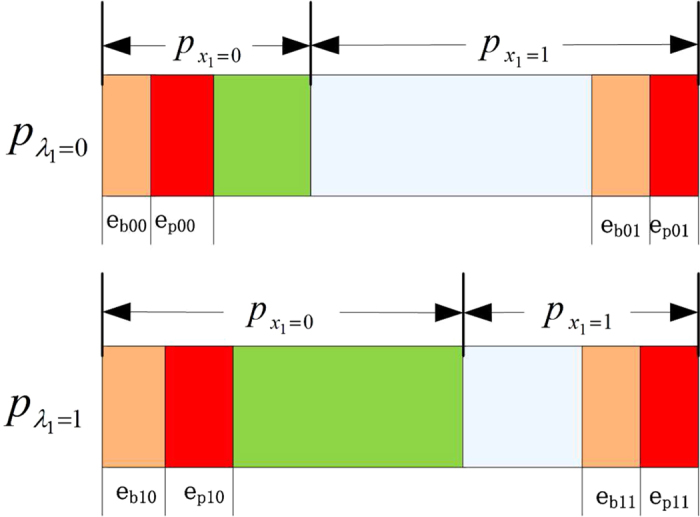
The basis selection deviation is controlled by the hidden variable λ1, different λ1 value has different basis selection probability p(x1|λ1).For given hidden variable λ1 = 0, eb00 and eb01 are bit error rates introduced in the rectilinear basis and diagonal basis, while ep00 and ep01 are phase error rates introduced in the rectilinear basis and diagonal basis respectively. For given hidden variable λ1 = 1, eb10 and eb11 are bit error rates introduced in the rectilinear basis and diagonal basis, while ep10 and ep11 are phase error rates introduced in the rectilinear basis and diagonal basis respectively.